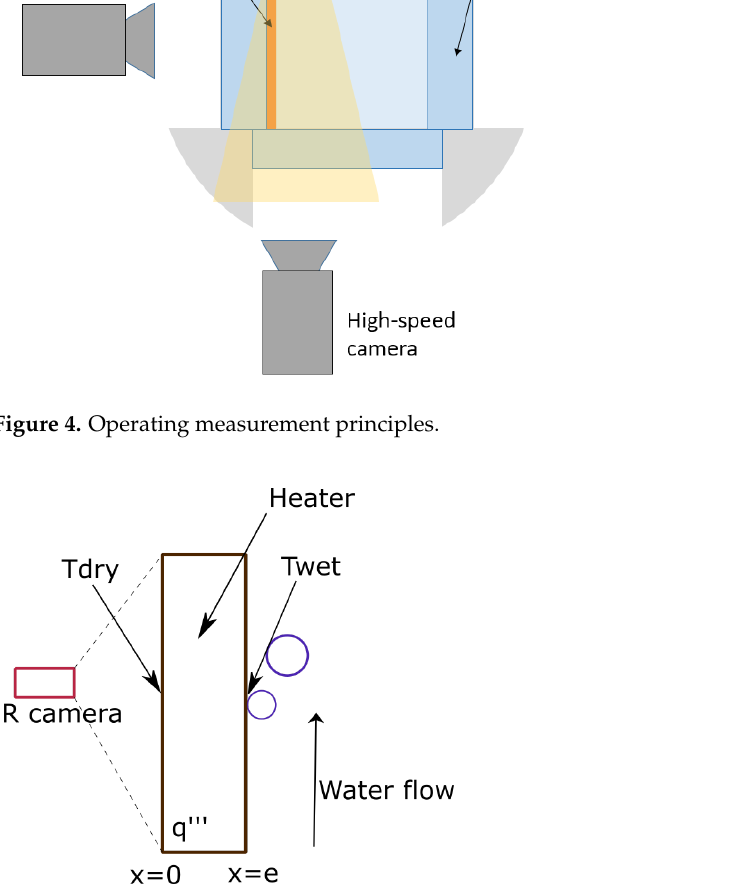
Figure 5. Schematic diagram of IR thermography measurements and thermal conductive